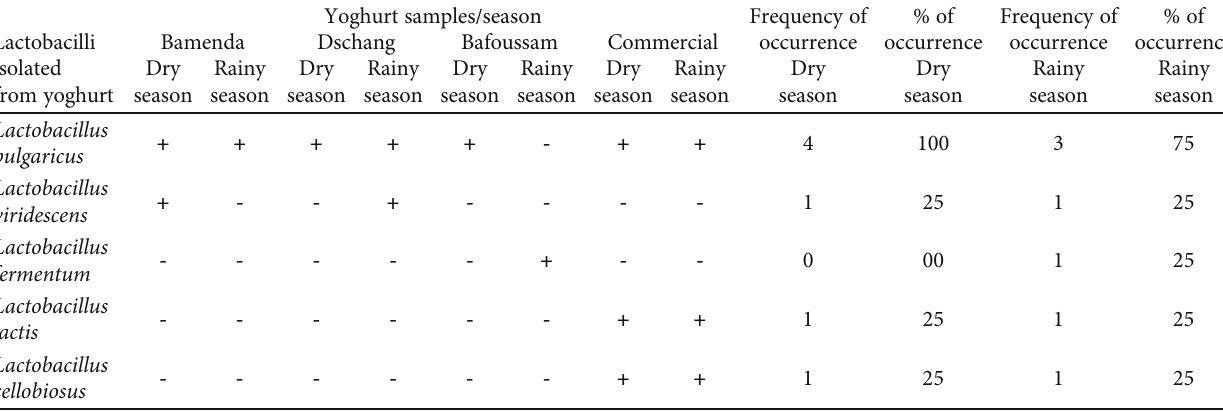
Table 3: The distribution of lactobacillus species as a function of place.